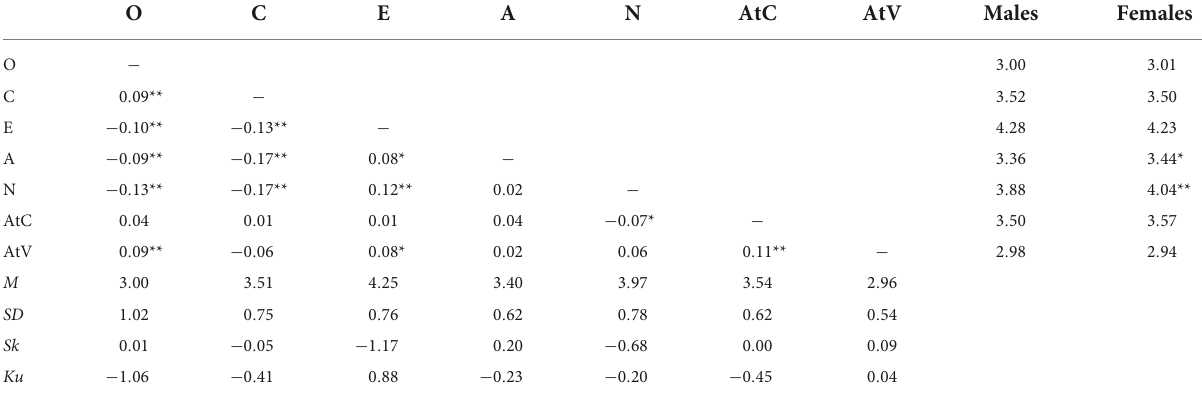
TABLE 1 Descriptive statistics, gender differences and intercorrelation of